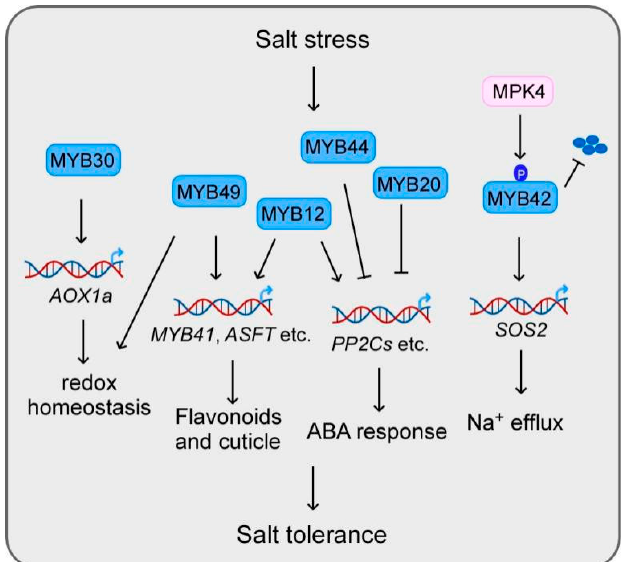
Figure 2. MYB transcription factors participate in salt stress through the regulation of downstream target genes. MYB44 and MYB20 positively regulate plant salt tolerance through the repression of key ABA repressor, PP2Cs [36,61]. MYB42 enhanced the expression of SOS2 to facilitate Na + efflux, while MPK4 phosphorylates MYB42 to protect it from degradation under salt stress [62]. MYB30 activates AOX1a expression to keep cellular redox homeostasis and MYB49 modulates cuticle formation and antioxidant defense [60,63]. Besides its role in flavonoids and cuticle formation, MYB12 can also induce the expression of ABA biosynthesis genes to confer plant salt tolerance [25].